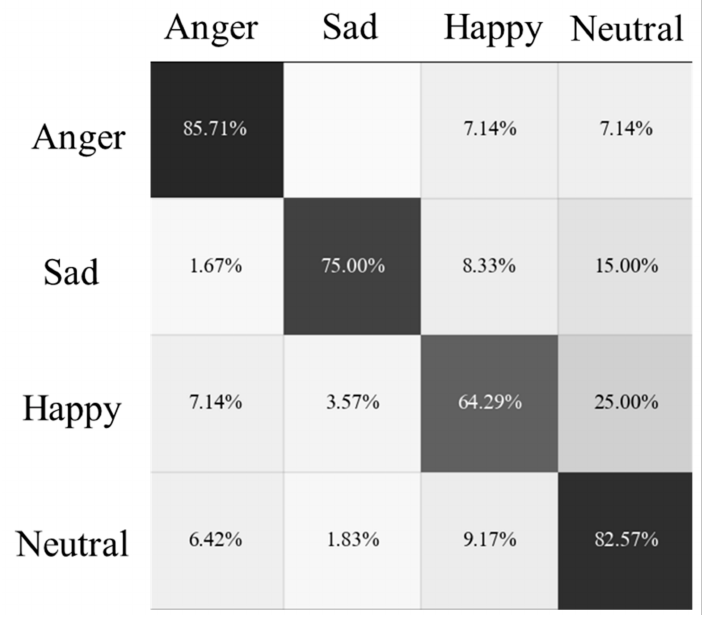
Figure 10. Confusion matrix of unweighted accuracy 76.89% of